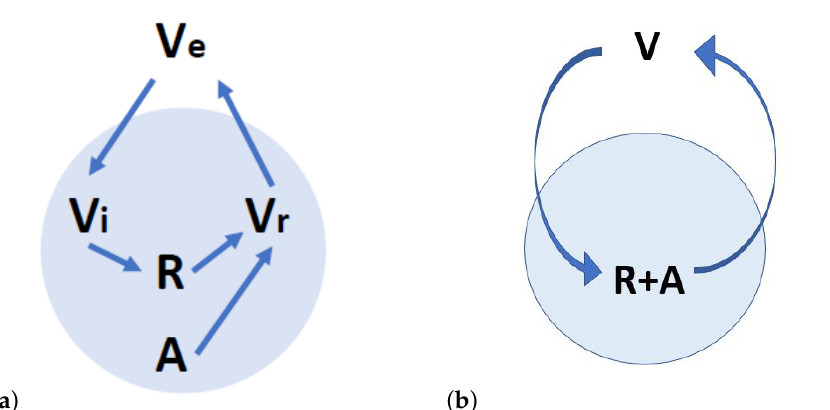
Figure 1. Basic model considered in this work ( a ) with extracellular virus V e , intracellular virus V i , viral genetic material R , and intracellular proteins A participating in virus replication and production of new virus particles V r . In the reduced model ( b ), two intermediate stages are